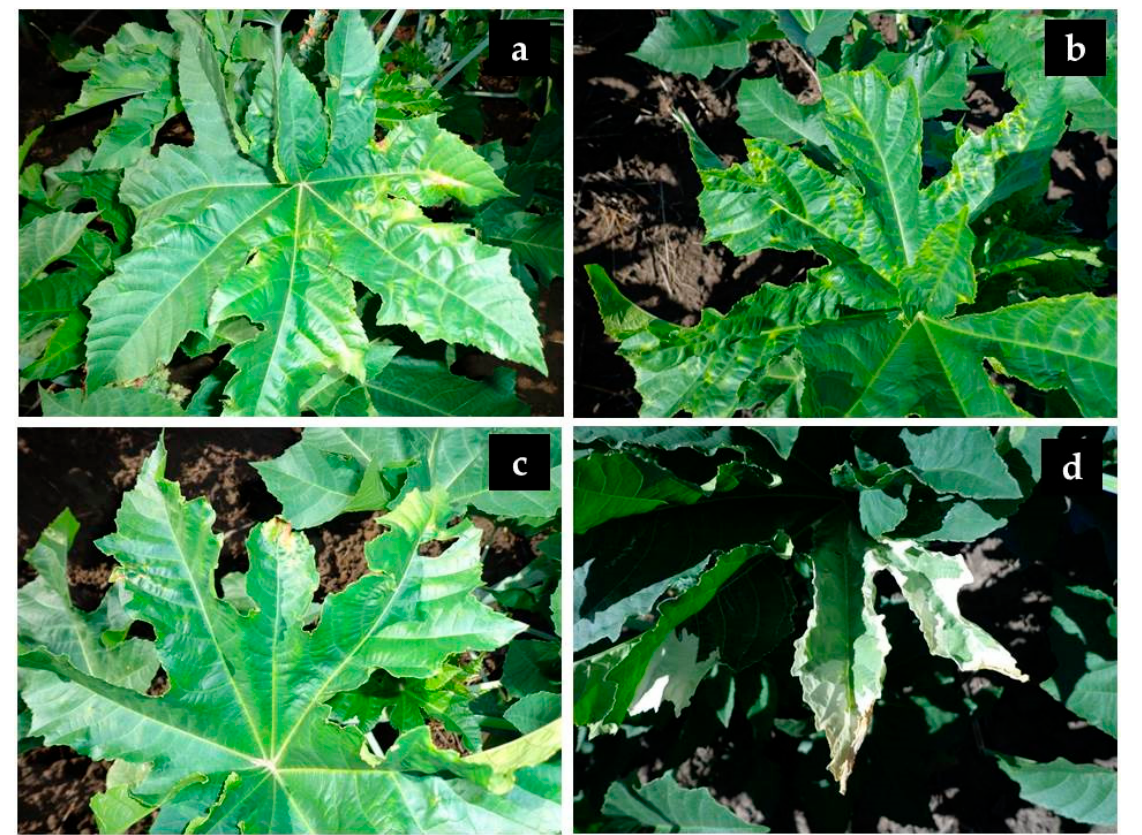
Figure 1. Details of visual injuries of castor leaves caused due to chlorimuron-ethyl ( a ), ethoxysulfuron ( b ), halosulfuron-methyl ( c ), and metamitron ( d ) on 35 days after the second postemergence application in the second experiment.